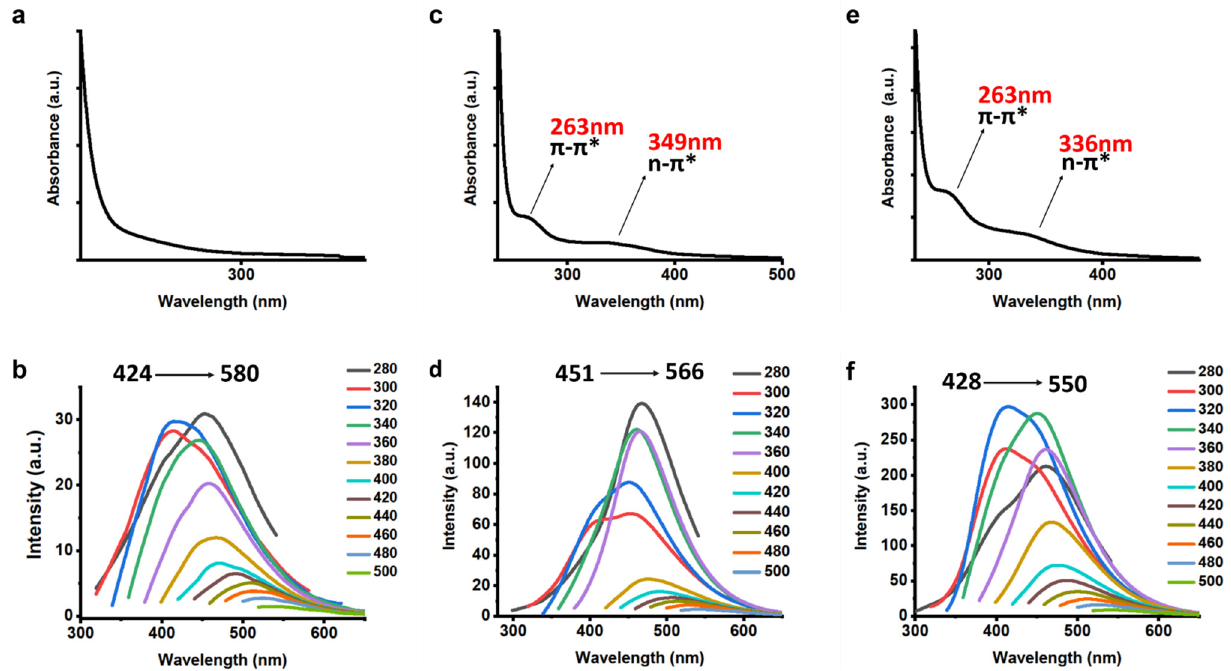
Figure 2. UV-vis and fluorescence spectra collected at different excitation wavelengths of CQDs prepared at different synthesis temperatures: 140 °C ( a , b ), 180 °C ( c , d ), and 220 °C ( e , f ). The synthe- prepared at different synthesis temperatures: 140 ◦ C ( a , b ), 180 ◦ C ( c , d ), and 220 ◦ C ( e , f ). The synthesis sis time and the ratio of precursors were set as 12 h and 1:1 M:M, respectively. time and the ratio of precursors were set as 12 h and 1:1 M:M,